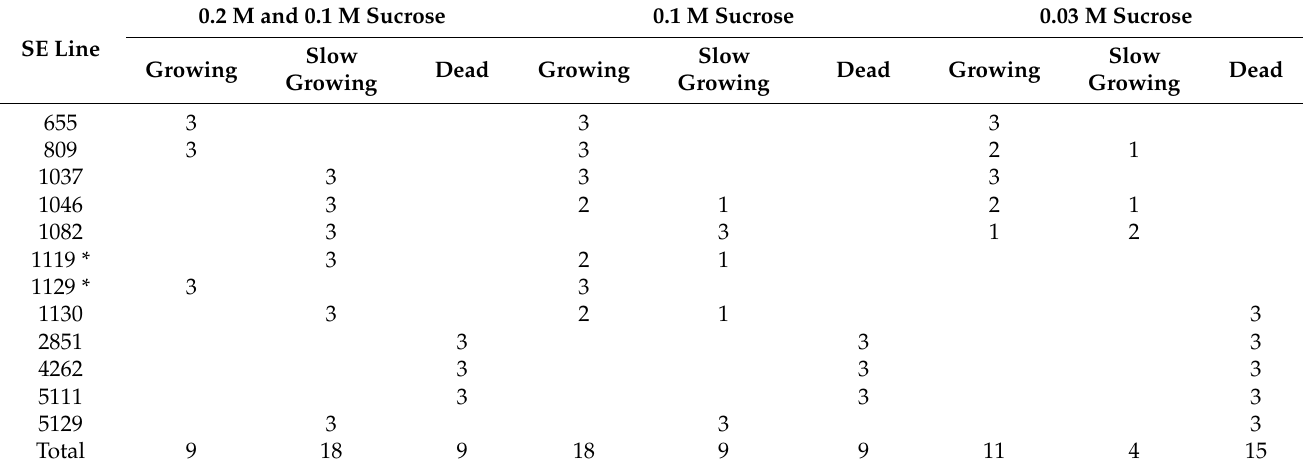
Table 2. Number of samples regenerated after cryopreservation and different thawing treatments. The three treatments were 24 h both in 0.2 M and 0.1 M sugar concentration LM media before the proliferation media (0.03 M sucrose), 24 h in a 0.1 M sucrose concentration before proliferation media and placing samples directly on LM proliferation media (0.03 M sucrose concentration). Three cryovials containing embryogenic tissue from the same genotype from every experimental media were stored in LN.